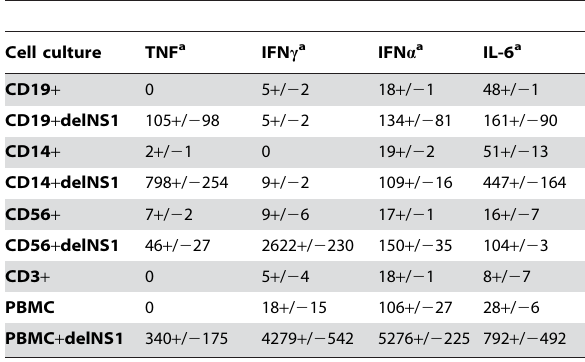
Table 2. Cytokine production after virus infection of CD19 + , CD14 + , CD56 + , CD3 + monocultures and PBMCs.